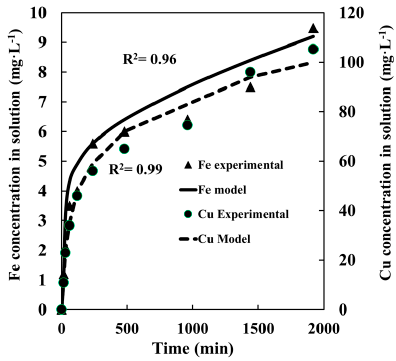
Figure 3. Iron and copper concentrations in solution for the chalcopyrite leaching system.